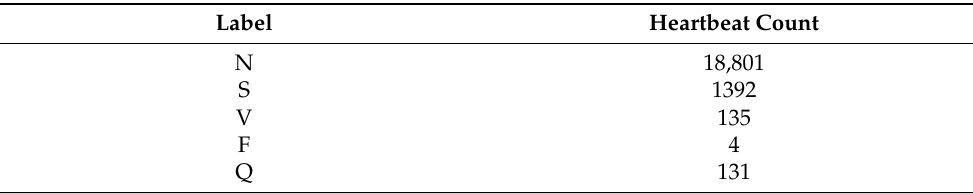
Table 9. Number of heartbeats for each classification label.